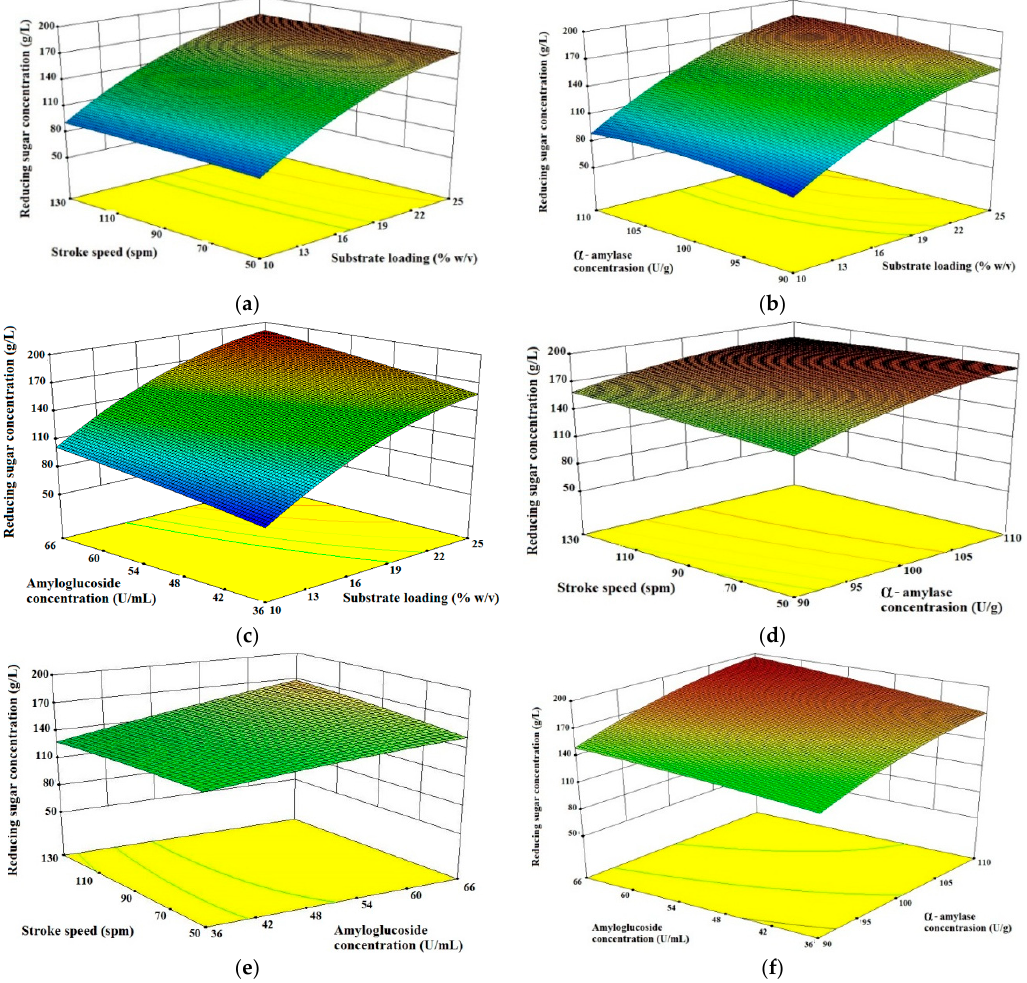
Figure 2. Three-dimensional surface plot of reducing sugar concentration for: ( a ) substrate loading and stroke speed; ( b ) substrate loading and α -amylase concentration; ( c ) substrate loading and amyloglucosidase concentration; ( d ) α -amylase concentration and stroke speed; ( e ) amyloglucosidase concentration; and stroke speed; and ( f ) amyloglucosidase concentration and α -amylase concentration